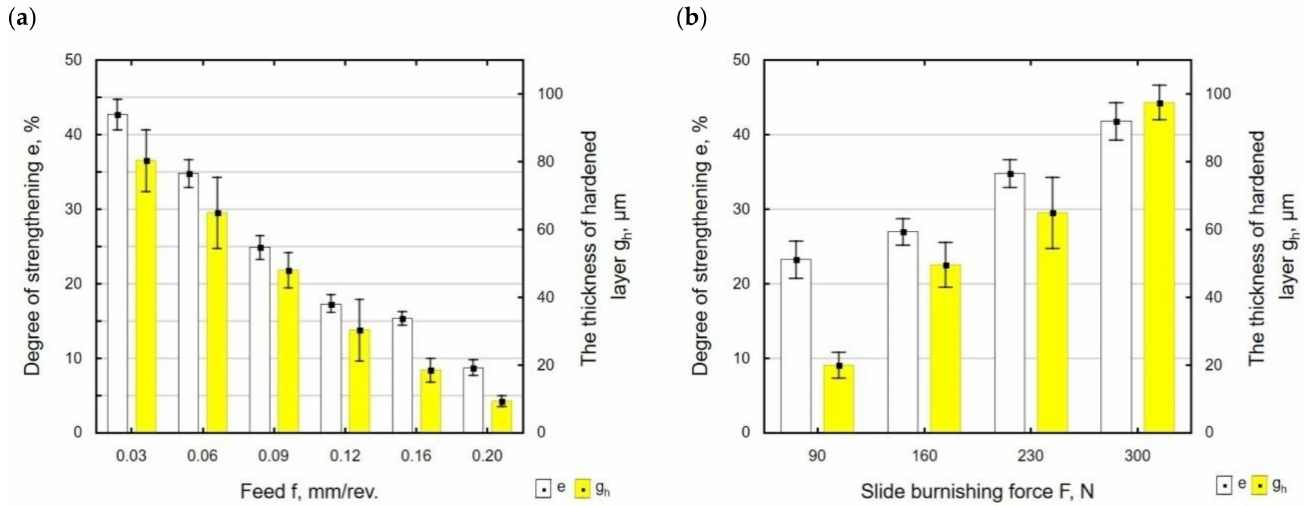
Figure 13. Degree of strengthening and hardened layer thickness after slide burnishing as a function of: ( a ) feed f ( F = 230 N, v n = 35 m/min, i = 1); ( b ) force F ( f = 0.06 mm/rev., v n = 35 m/min, i =